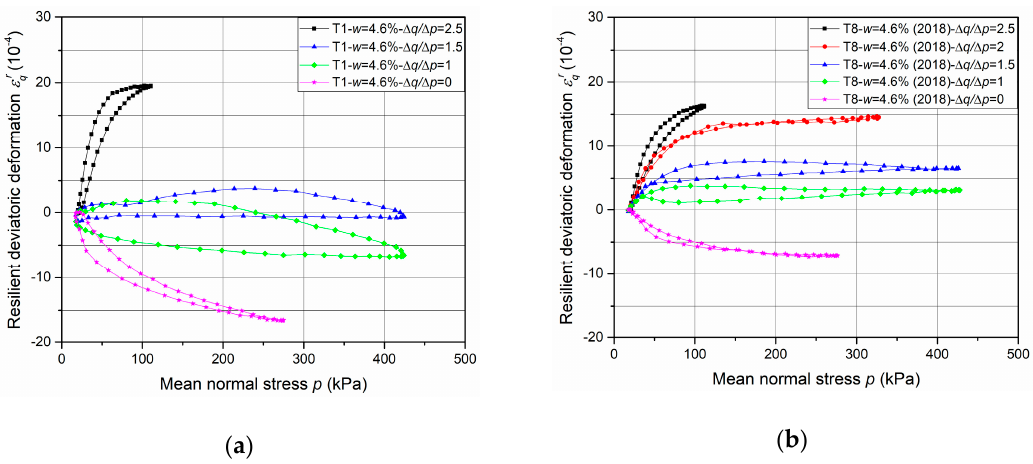
Figure 14. Resilient deviatoric deformation ε qr with different fixing methods: ( a ) T1- w = 4.6%-screw; ( b ) T8- w = 4.6%-tube.